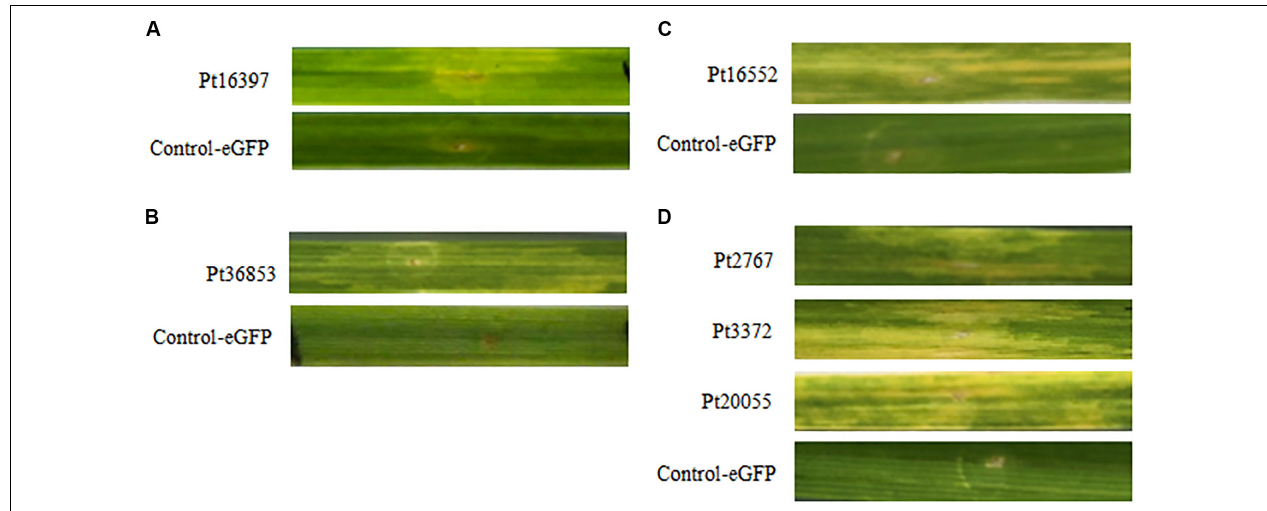
FIGURE 5 | Six candidate secreted effector proteins (CSEPs) of P. triticina can especially induce hypersensitive response (HR) on the wheat near-isogenic lines. (A–C) Phenotype of Pt16397 , Pt36853 , and Pt16552 inoculated on wheat near-isogenic lines TcLr26, TcLr47, and TcLr41, respectively. (D) Pt7277 , Pt88286 , and Pt3372 play role in